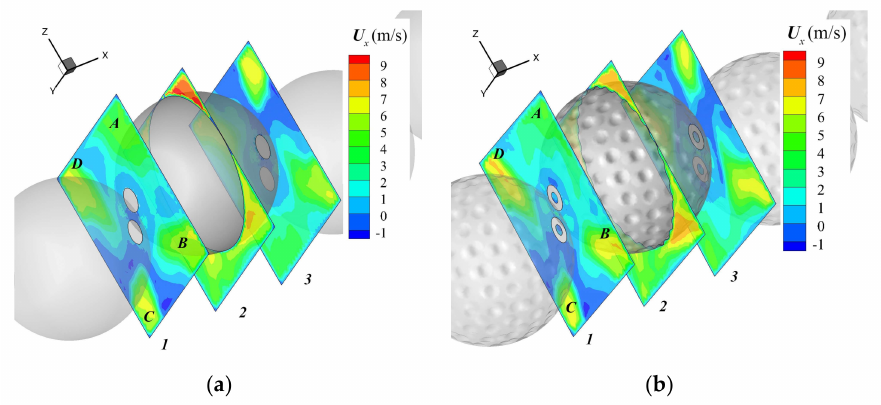
Figure 15. The streamwise velocity in the cross sections of ( a ) SPBS and ( b ) SPBD at N = 1.15 ( Re H = 4599).